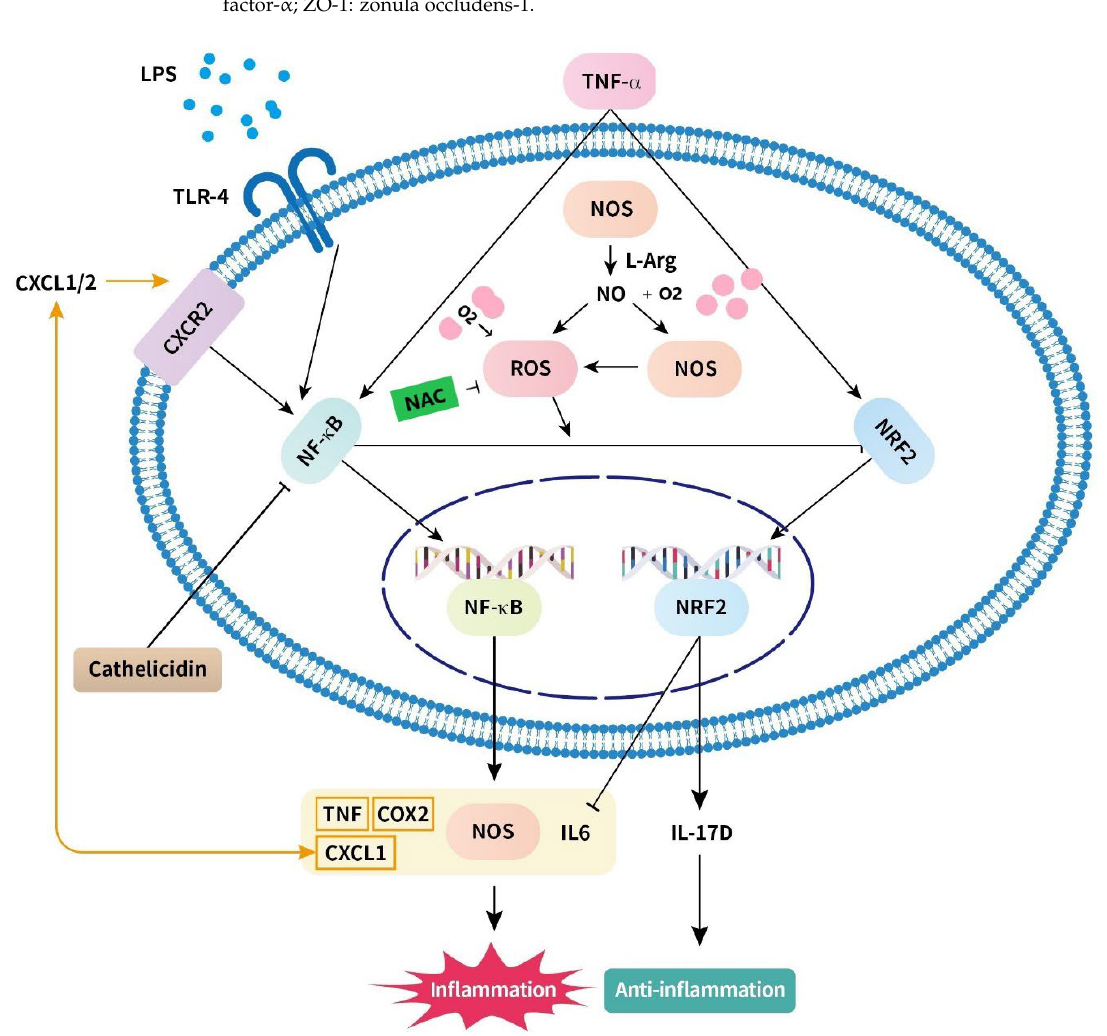
Figure 1. Schematic of the mechanism of hyperoxia-induced intestinal inflammation and anti-inflammatory response. Hyperoxia increases NOS and causes NO dysregulation and NO interacts with oxygen to became oxidated. Excessive NO induces the production of ROS. Furthermore , hyperoxia increases production of ROS. ROS causes inflammation through the NF - κB pathway and inhibits the Nrf2 pathway, which plays a crucial role in anti-inflammatory response. Production of inflammatory cytokines, including TNF, COX2, CXCL1, and IL-6, enhances inflammatory injury. CXCL1 activates CXCR1/2 and induces the NF - κB pathway . Under hyperoxic conditions, levels of